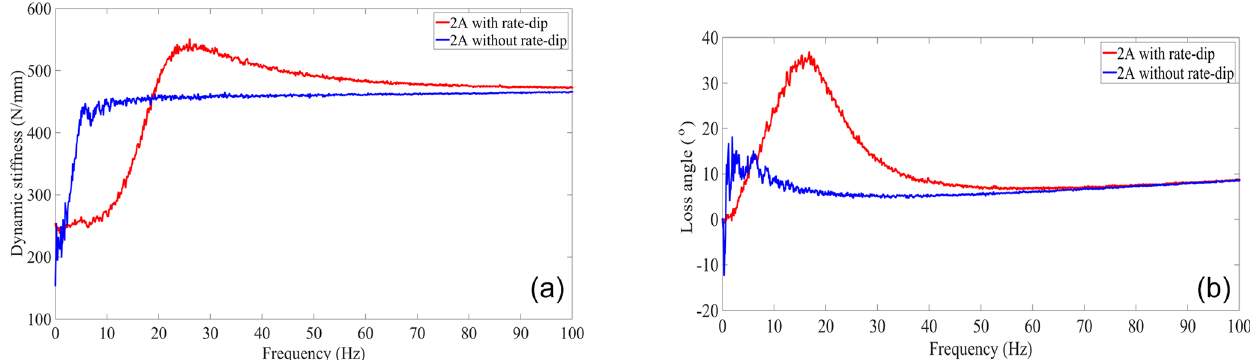
Figure 13. Effect of the presence or absence of the rate-dip channel on the dynamic characteristics of MR fluid mount (a) dynamic stiffness and (b) loss angle.